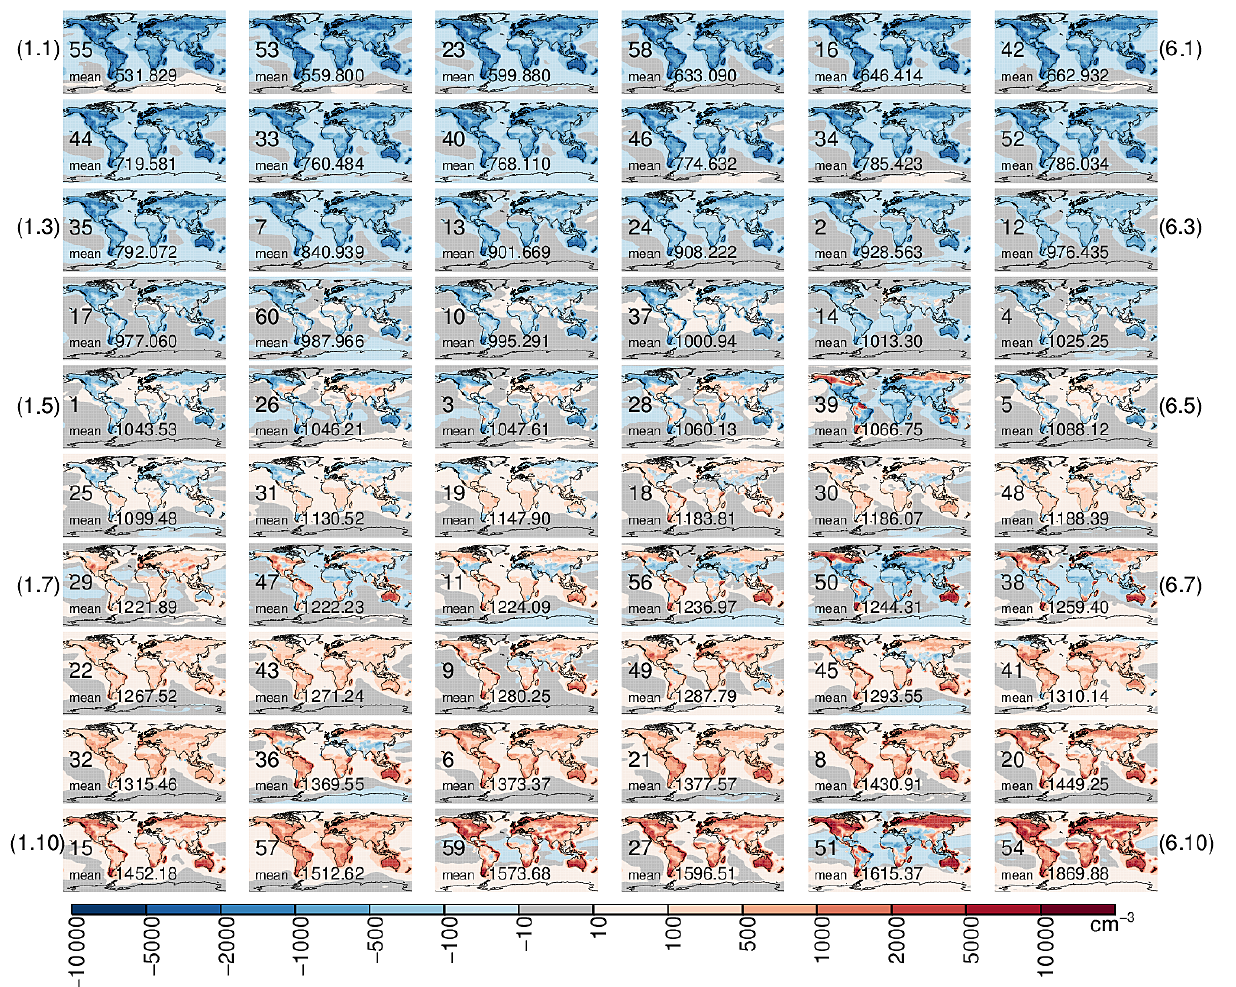
Figure 5. Global annual mean anomaly of N3 number concentration at the surface (cm − 3 ) produced within the ensemble. Each subplot shows the anomaly of an ensemble member (numbered between 1 and 60) from the ensemble mean N3. The global mean N3 is given on each subplot. The subplots are arranged in order of increasing global mean